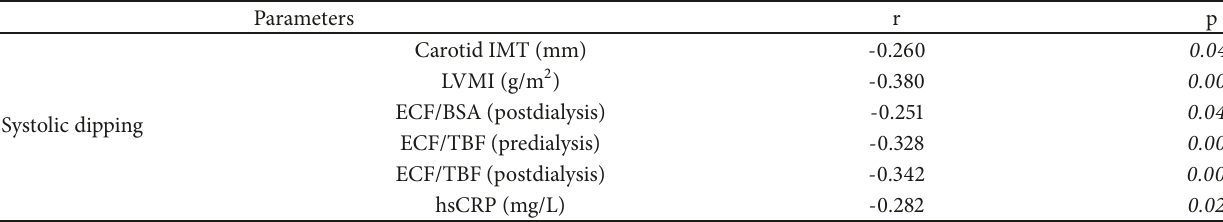
Table 5: The correlation between some parameters in all patients.